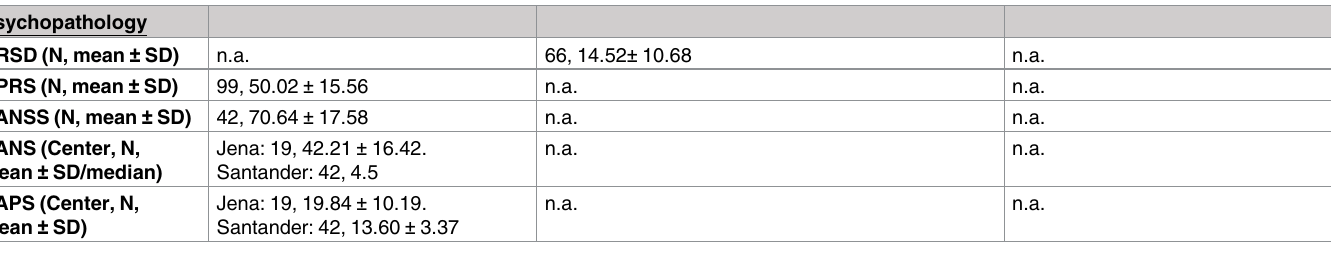
SCZ: schizophrenia. BD: bipolar disorder. HC: healthy controls. HRSD: Hamilton Depression Rating Scale. BPRS: Brief Psychiatric Rating Scale. PANSS: Positive And Negative Syndrome Scale. SAPS/SANS: Scales for Assessment of Positive/Negative symptoms. SD: standard deviation. The median value is indicated in case of non-normal